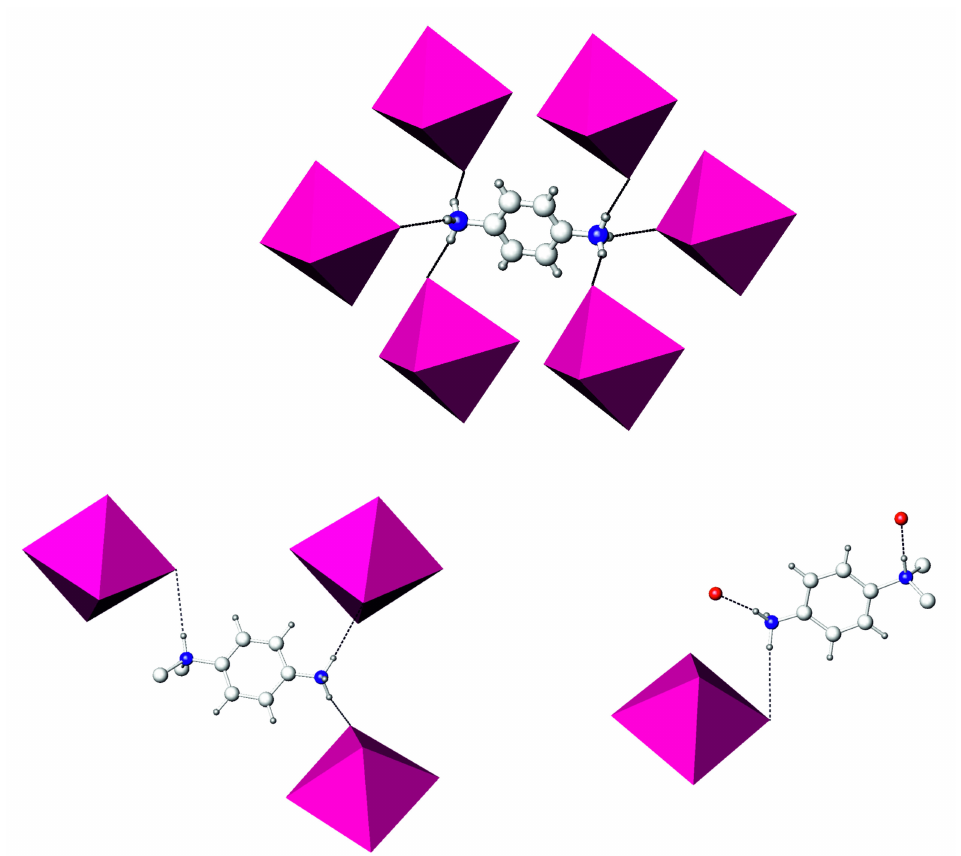
Figure 6. Local coordination of diammonium cations in the crystal structures of 3 ( top ) and 4 ( bottom ). [BiI 6 ] octahedra, purple; oxygen, red; nitrogen, blue; carbon, light gray; hydrogen, dark gray. Hydrogen (N)H ··· O and (N)H ··· I bonds are shown as dashed lines. Not all hydrogen atoms are shown for